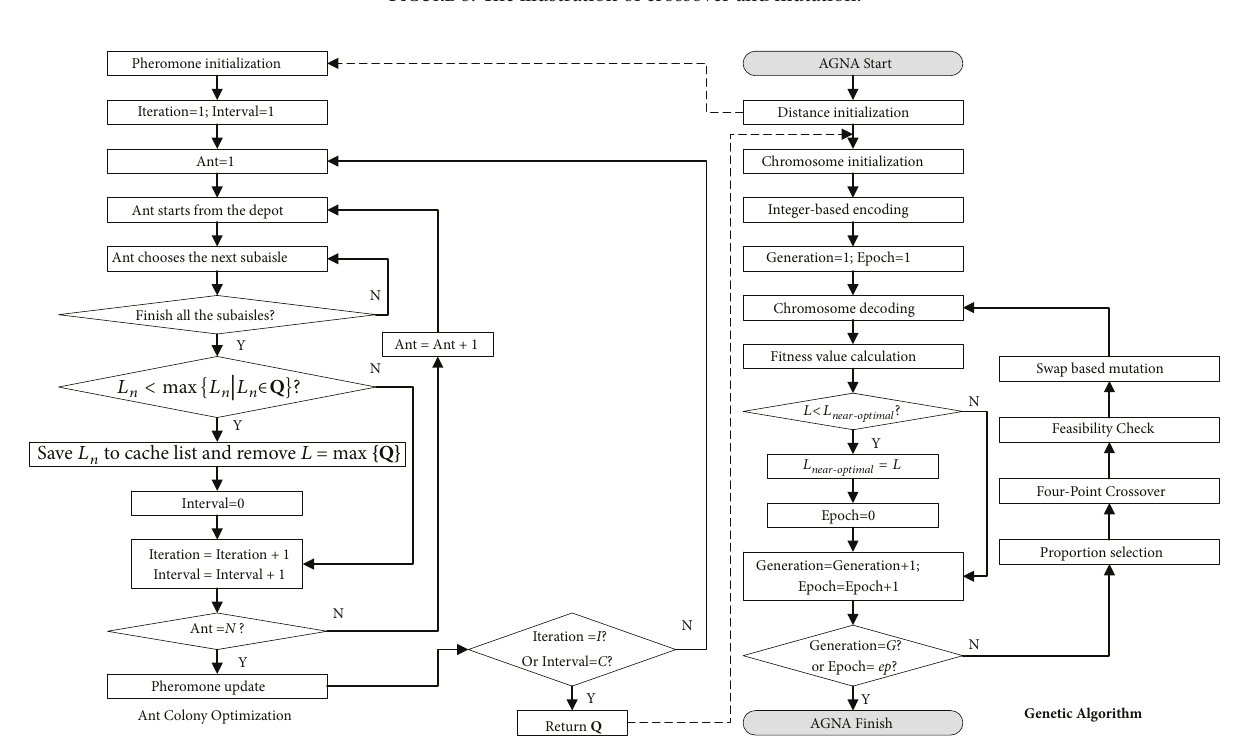
Figure 9: The flowchart of AGNA